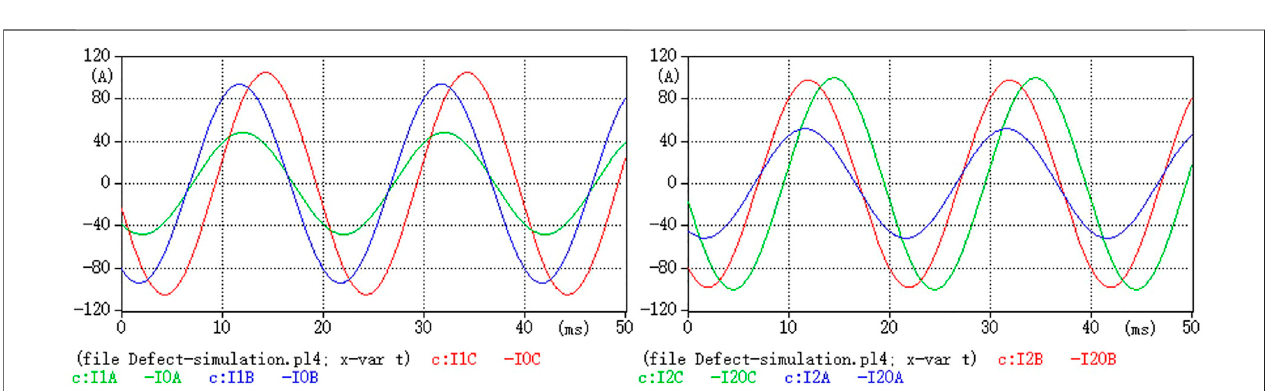
FIGURE 7 | Simulation results of the induced current of the cable sheath under normal operation.